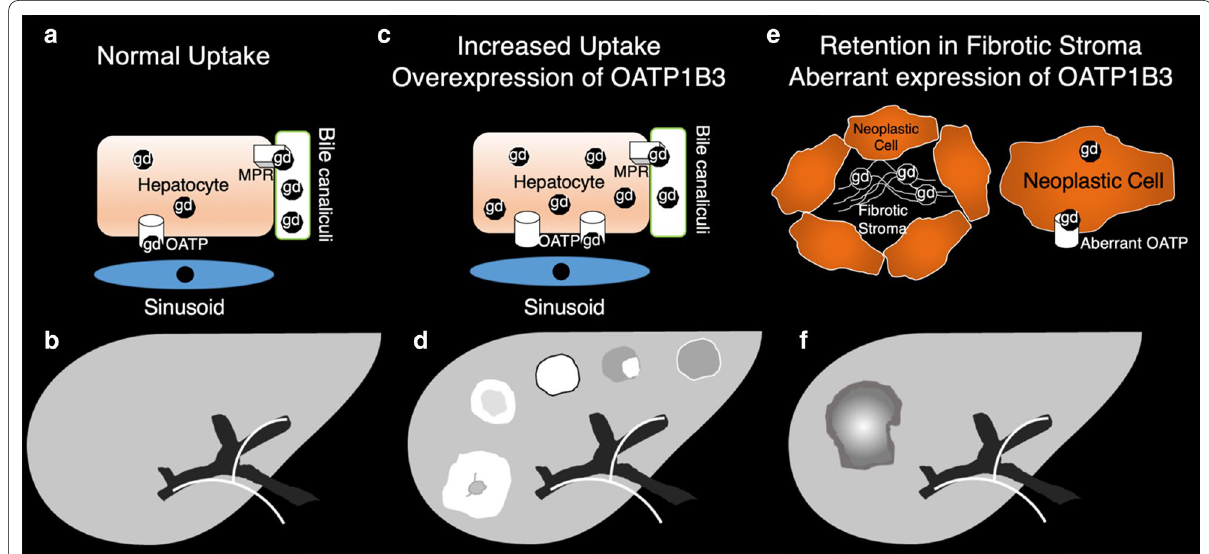
Fig. 1 Top row: schematics showing the uptake mechanism of hepatobiliary contrast agents. Bottom row: corresponding schematics of the signal characteristics of liver and focal observations. Left column: a uptake in hepatocytes and ( b ) corresponding signal characteristics in normal liver. Middle column: c increased uptake due to overexpression of OATP1B3 and ( d ) corresponding iso‑ or hyperintense signal characteristics of focal observations (from left to right: FNH, nodule with hyperintense rim, hyperintense HCC, HCC with nodule‑in‑nodule architecture and HCC with peritumoral hyperintensity). Right column: e increased uptake due to retention in fibrotic stroma or aberrant expression of OATP1B3 and ( f ) representative target imaging appearance (lower row) of intrahepatic cholangiocarcinoma or